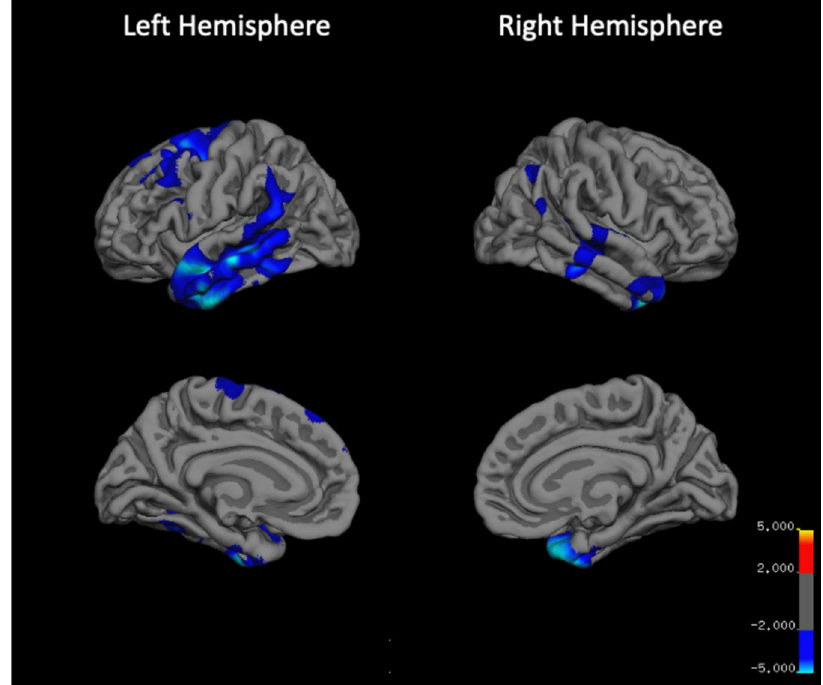
Fig. 2 Cortical thinning over 12 weeks after switching to clozapine treatment. Cortical thinning was evaluated as the symmetrized percentage change. The signi fi cance in the display is the − log10 P value, where blue represents areas of signi fi cant reductions in cortical thickness after 12 weeks of clozapine treatment. No areas of signi fi cant increase in cortical thickness were detected.